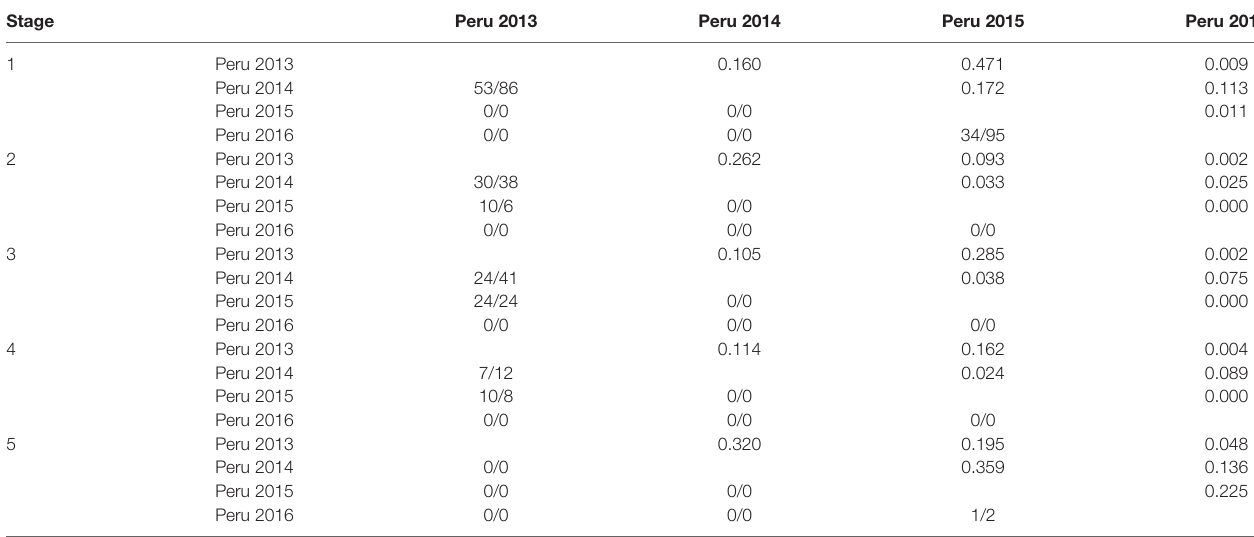
TABLE 7 | Annual variation in isotopic niche of males during different life stages.